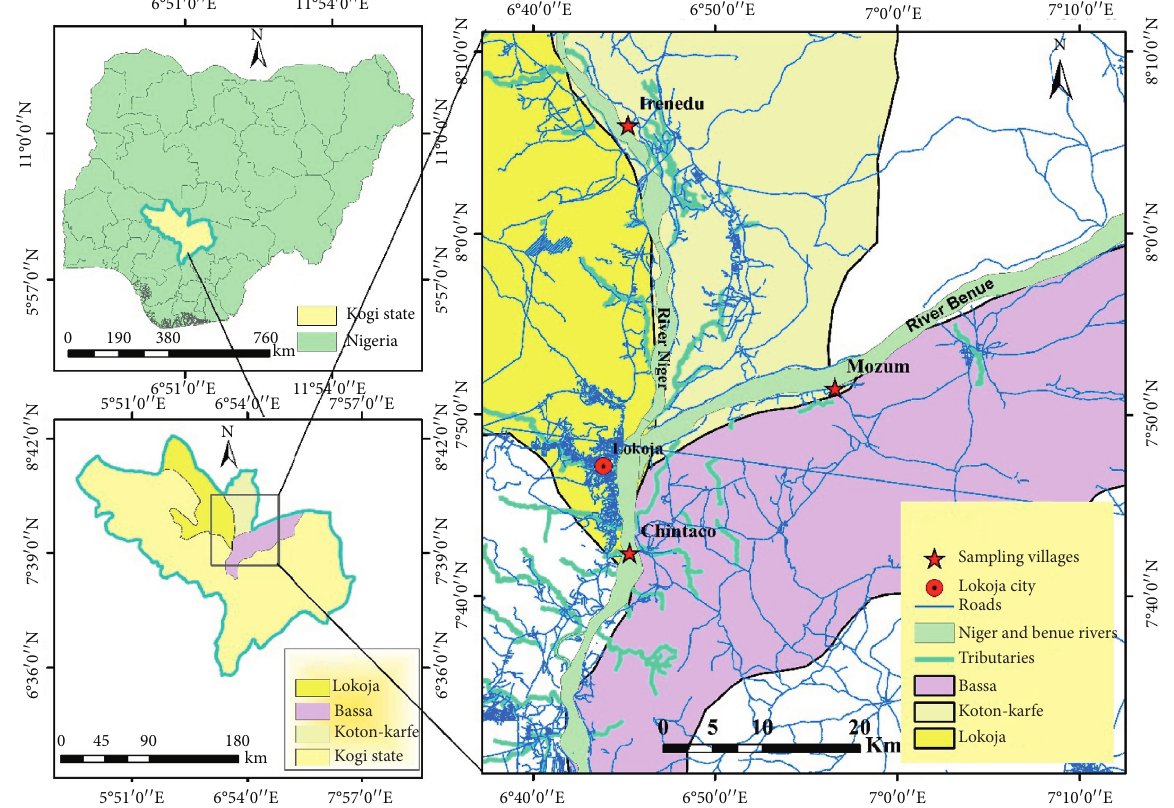
Figure 1: Map of sampling villages in the study area. Source: GIS unit, Geography Department, Kogi State University,